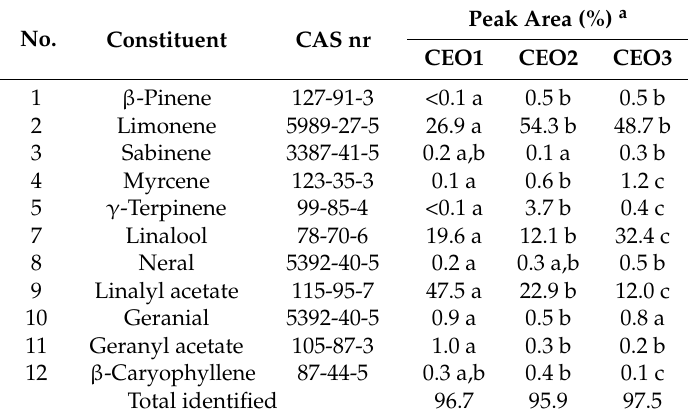
Table 1. Volatile components identified in CEOs.